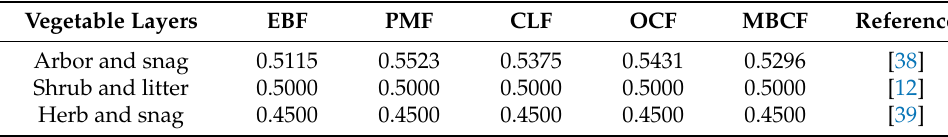
Table 3. Carbon concentration of different forest